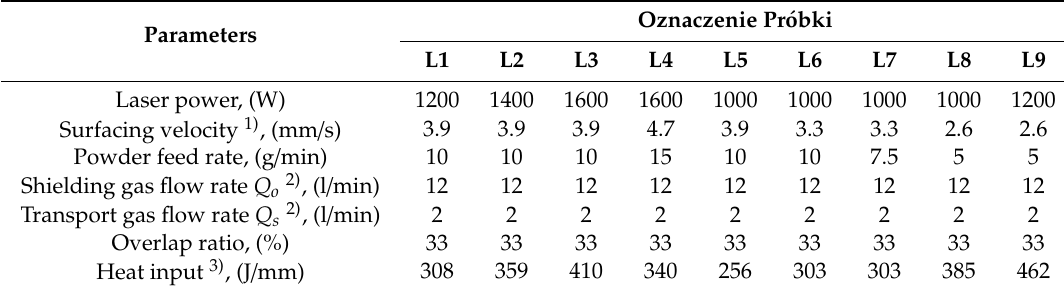
Table 7. Processing parameters of robotic laser powder surfacing of Inconel 625 superalloy layer on the outer surface of the 16Mo3 steel pipe.